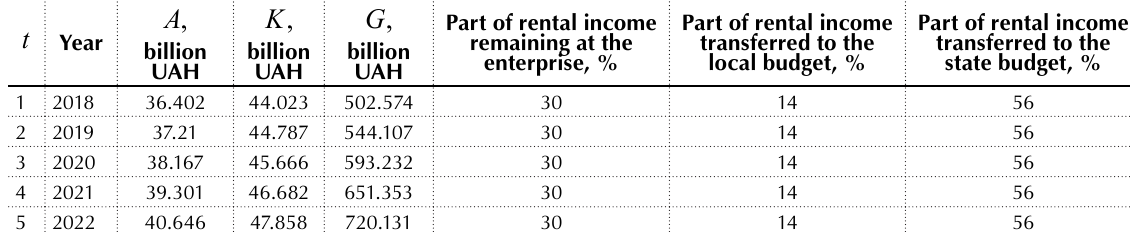
Table 1. The optimal distribution of rental income from the extraction of natural resources (constant